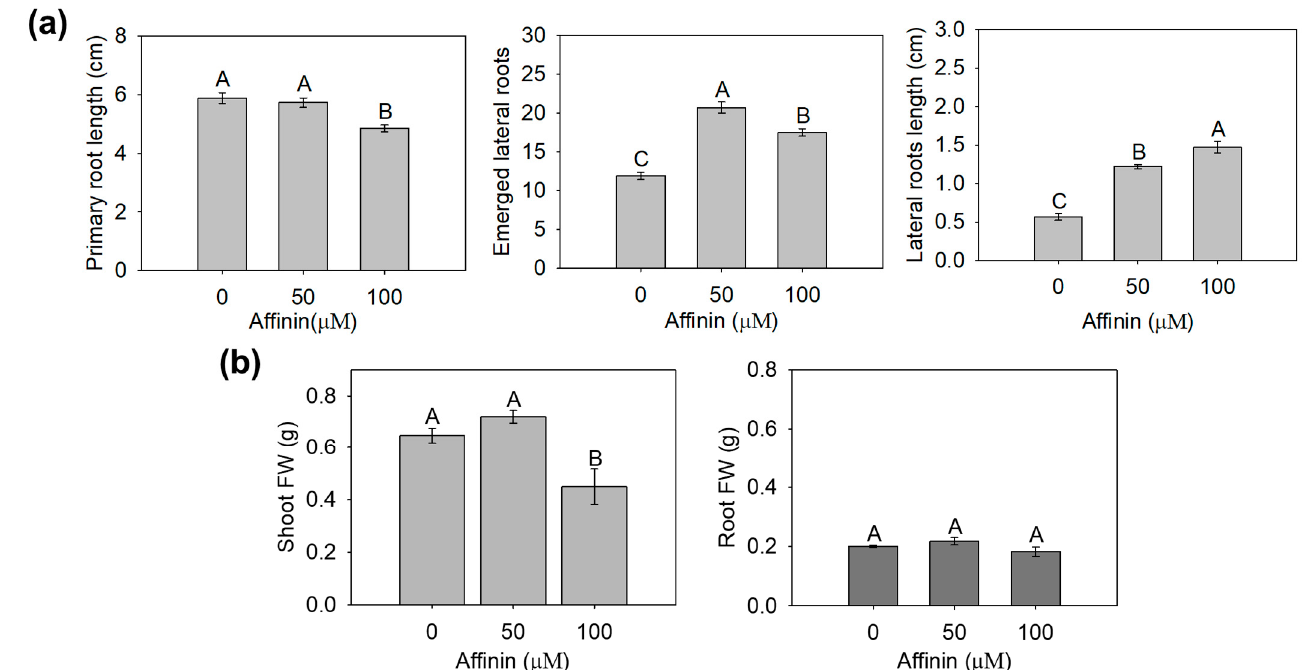
Figure 1. Changes in tomato seedlings root growth and morphology, induced by affinin treatment. Tomato seedlings were grown in a medium with or without the indicated affinin concentrations. After ten days, seedlings showed changes in: ( a ) primary root length (PRL), number of emerged lateral roots (eLRs), lateral roots length (LRL); ( b ) biomass expressed as fresh weight (FW) of five pooled shoots or roots with three biological repeats. Data were analyzed with one-way ANOVA and a Tukey test. Different letters (A–C) were used to indicate means that differ significantly ( p ≤ 0.05) ( n = 3).